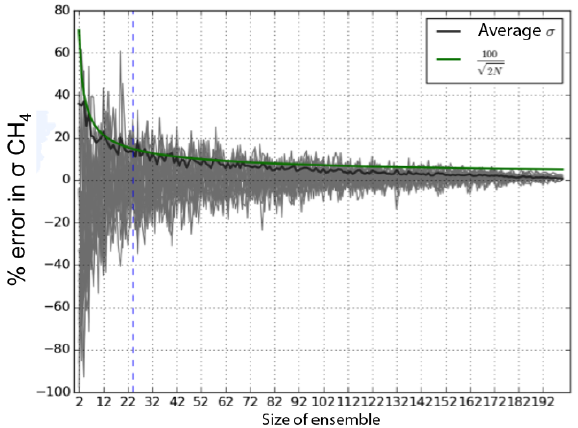
Figure B1. The gray lines represent the percentage error of 1 σ of ensemble size n from the σ of ensemble size of 200 of the a pri- ori CH 4 flux integrated over TransCom regions. The dark black line represents the average deviation in the gray lines. The green line represents the analytical variation of the error of 1 σ (Bousserez et al., 2015). A constant difference of approx. 6% between the esti- mates comes from the finite size of the largest sample